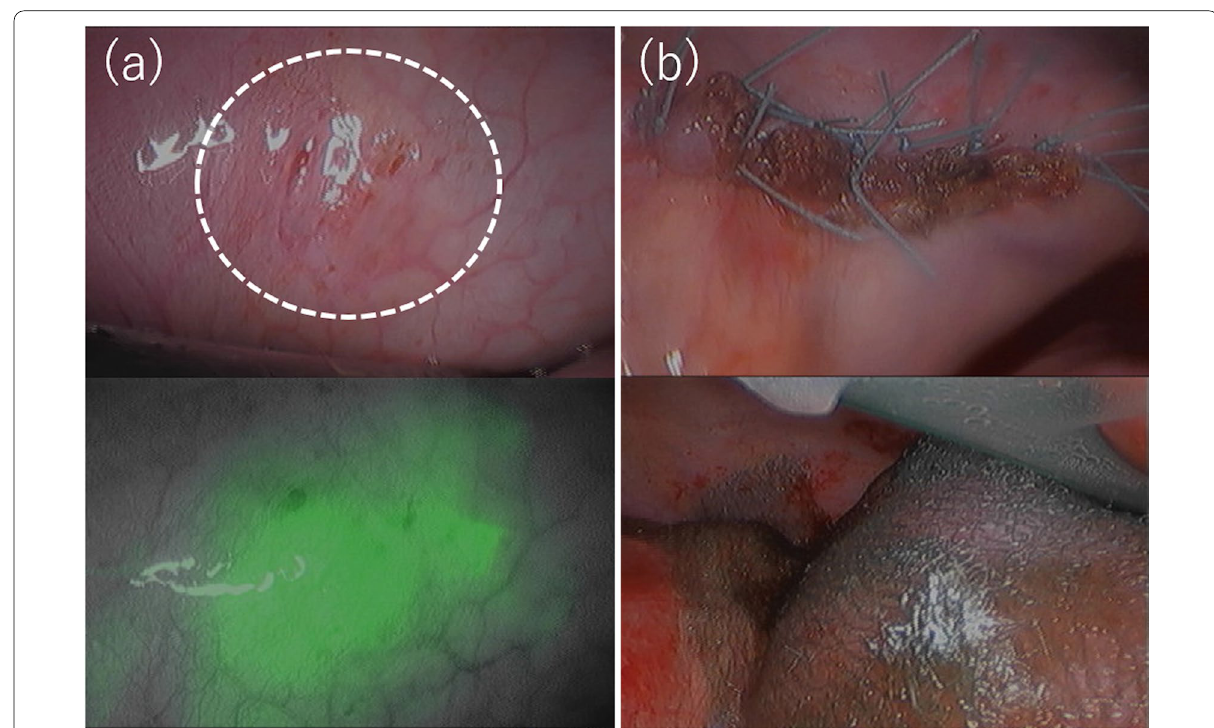
Fig. 5 Thoracoscopic findings. The pleural fluid was not stained, but an infrared camera detected fluorescence in the pleural effusion. a Small pores were detected. The fluorescence pleural effusion leaked from this site. b The lesion was excised and sutured directly, and a sheet of absorbable polyglycolic acid felt was fixed with fibrin glue onto the sutured